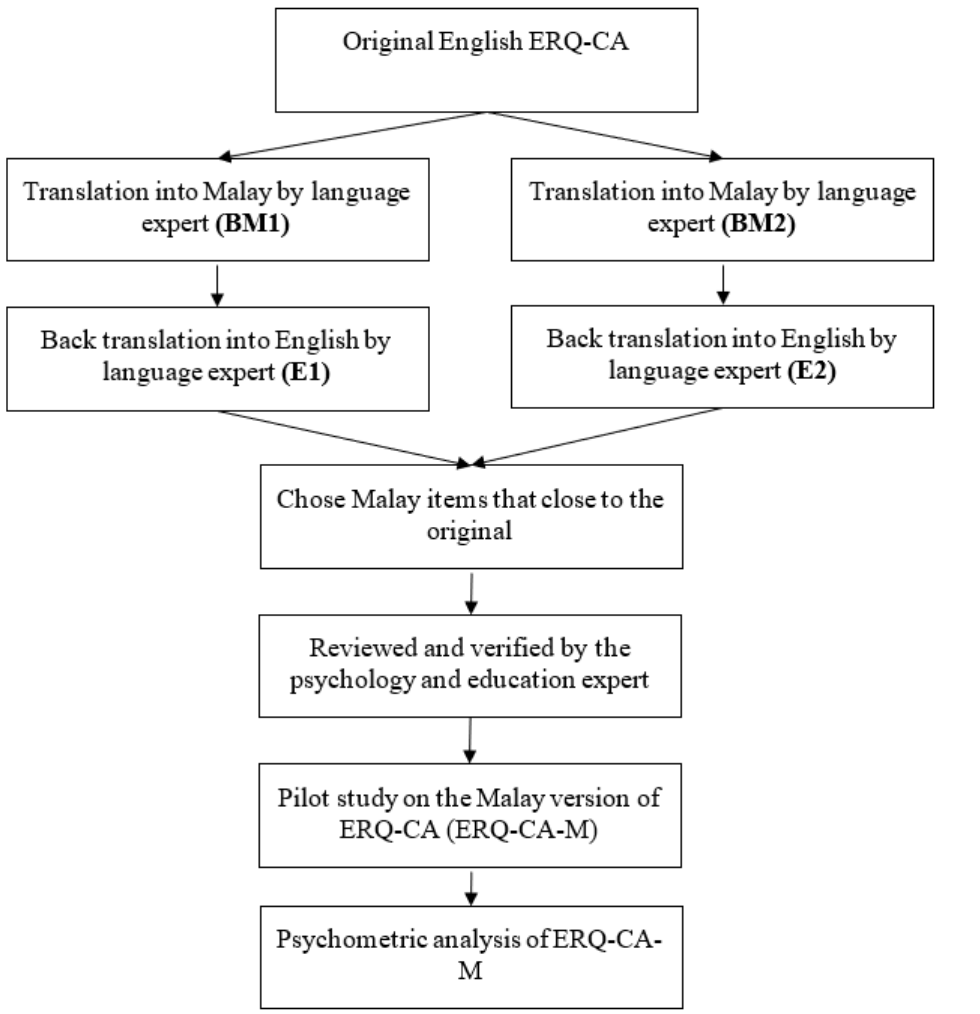
Figure 1. Overview of the translation and validation processes of the Malay version of the ERQ- CA.